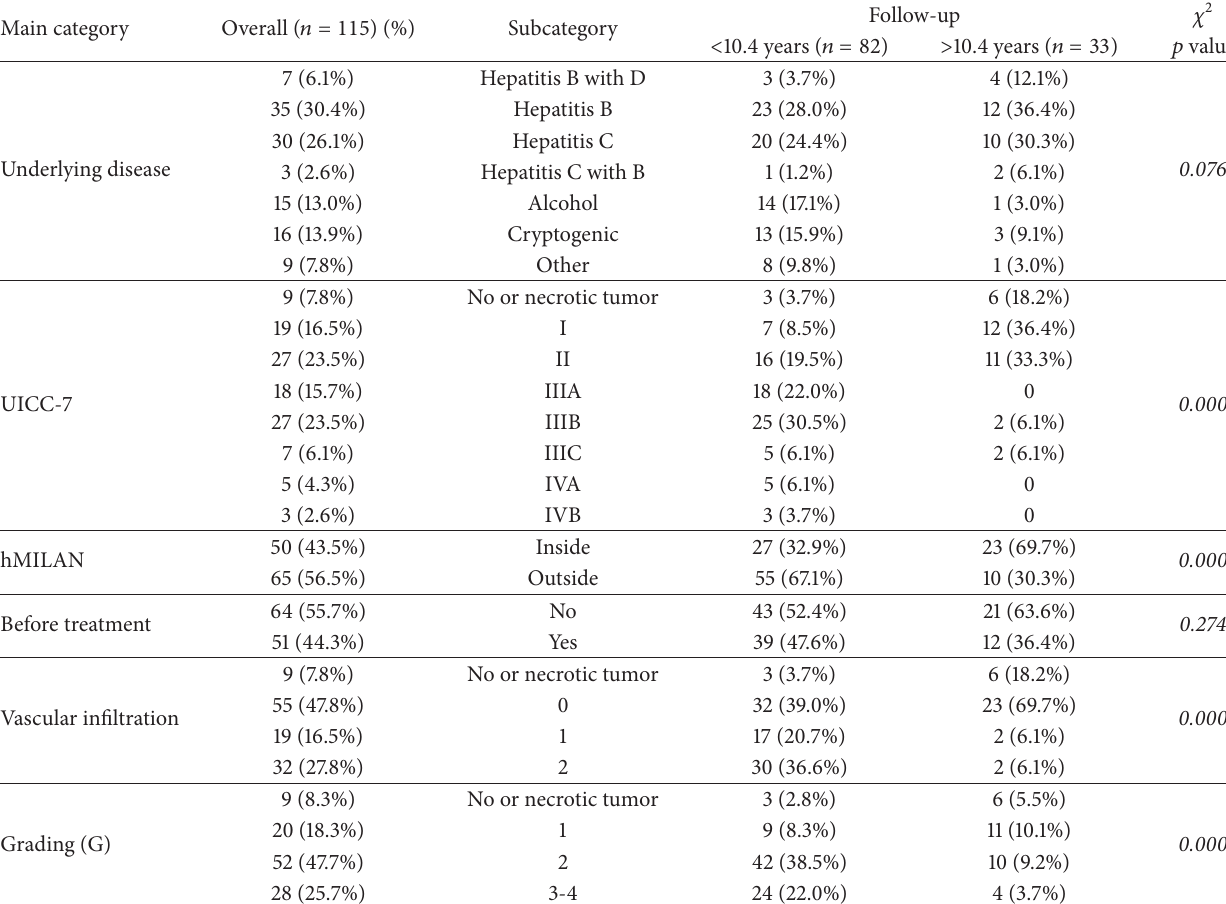
Table 7: Distribution of covariates and subcategories in HCCR versus HCCR-free postoperative episodes (cut-off time 10.4 years) ( 𝑛 = 115 ) (hospital deaths and patients without HCCR within 10.4 years